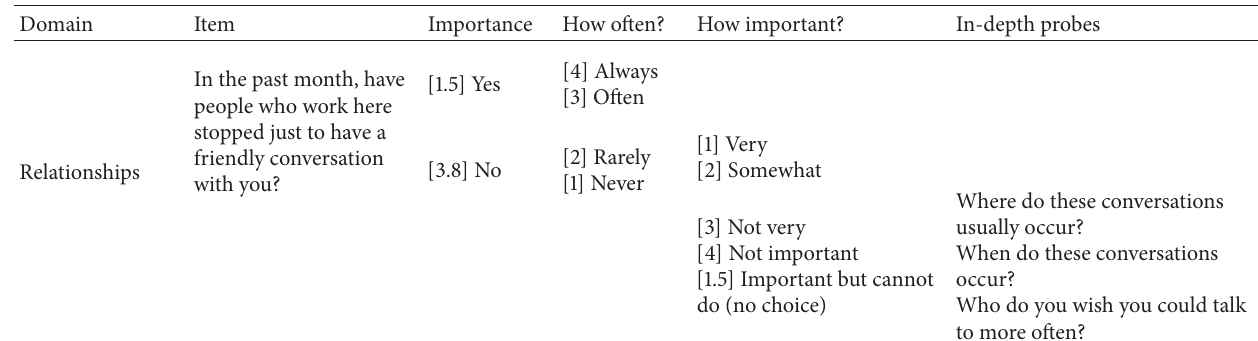
Table 2: Sample QOL.SRI